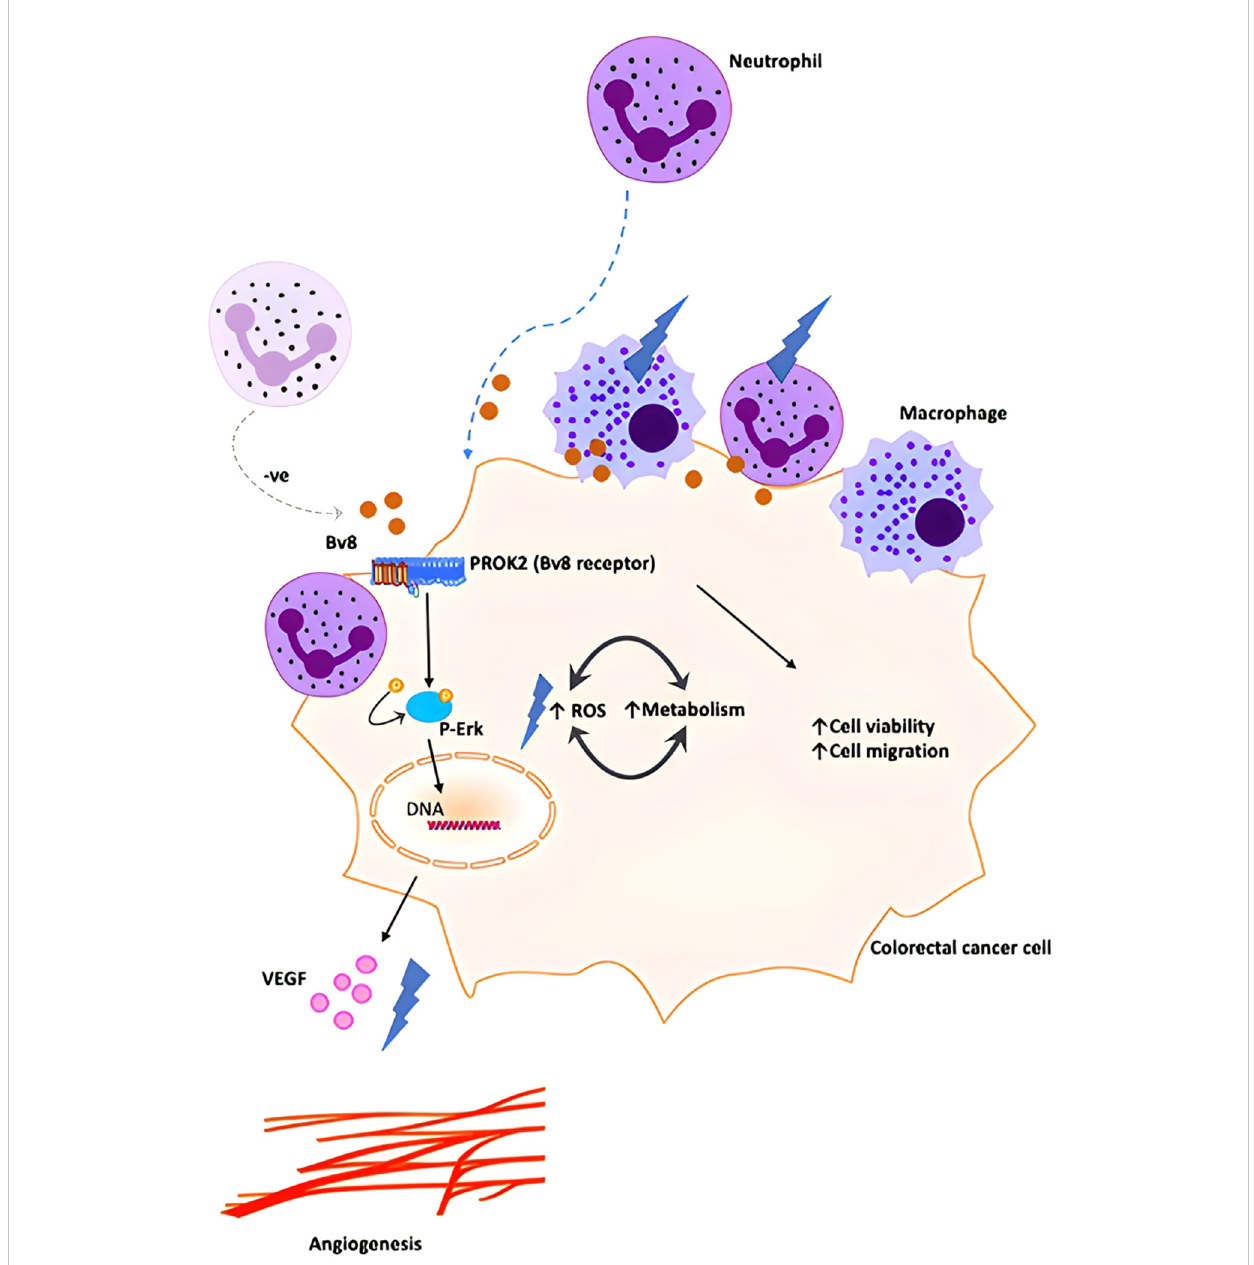
FIGURE 7 Schematic illustration of proposed orchestration of myeloid cells and CRC progression. We propose that small number of myeloid cells in fi ltrate into in fl amed colorectal tissue and secrete low level of Bv8 at the pre-cancer stage of CRC. Bv8 act as chemoattractant for myeloid cells. However, it is possible that the myeloid cell-CRC cell system actively regulates Bv8 at a low level to establish a pro-tumoral microenvironment (for example, myeloid cells might contribute to the negative regulation of Bv8 production in Caco-2 cells, maintaining Bv8 at a relatively low level.). Bv8 also promote tumorigenesis of CRC by enhancing VEGF-mediated angiogenesis and cancer cell metabolism, potentially through ErK signalling pathway. With the migration of myeloid cells, myeloid cell in fi ltration occurred and Bv8 was accumulated in CRC